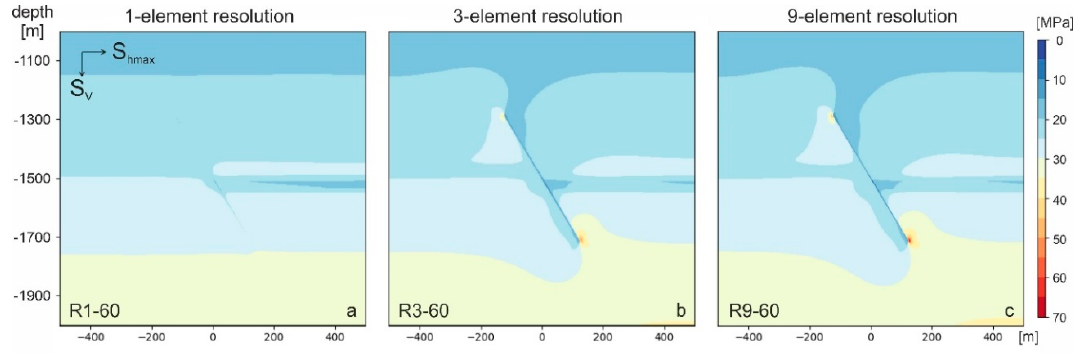
Figure 7. Spatial variations in the magnitude of the effective maximum principal stress (S 1,eff ) after the last load step for 1-element- ( a ), 3-element- ( b ) and 9-element- ( c ) wide fault zones dipping at 60° and using a rectangular grid.